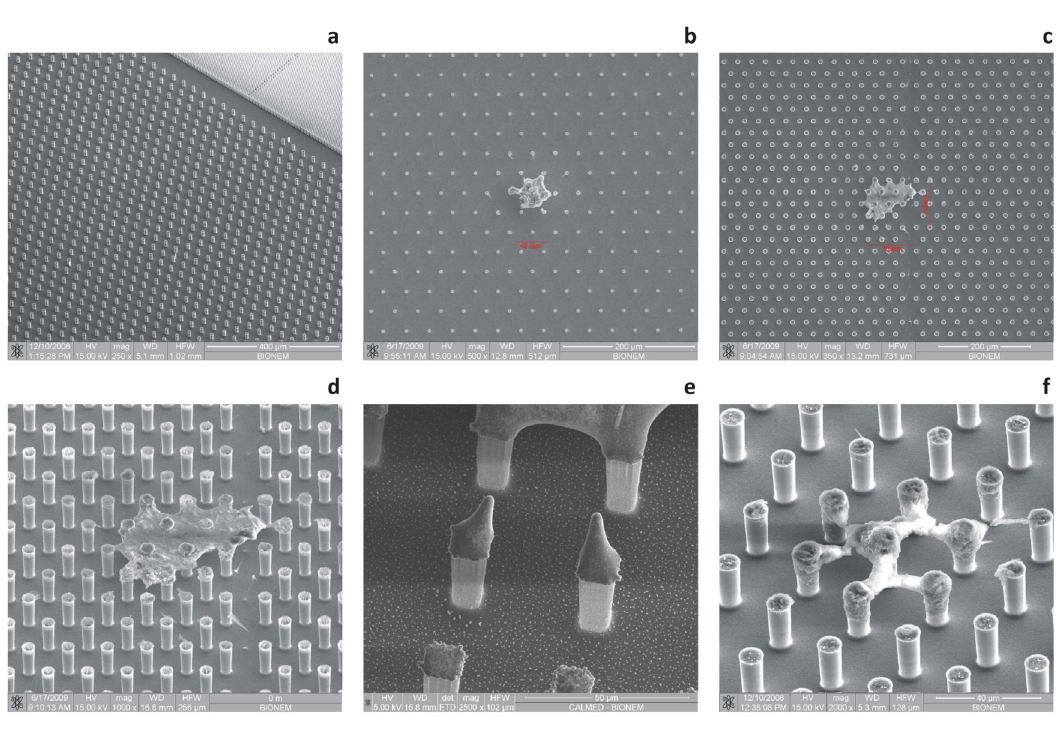
Figure 8. SEM micrographs showing the concentration ability of super-hydrophobic surfaces (SHSs). At the end of an evaporation process, a few molecules of solute are forced into a micrometric area; in this case, Rhodamine 6G, as it is used as a solute. From a – f , you can notice the residual solute upon evaporation, suspended upon few pillars. In some cases, as in f , the residue links adjacent